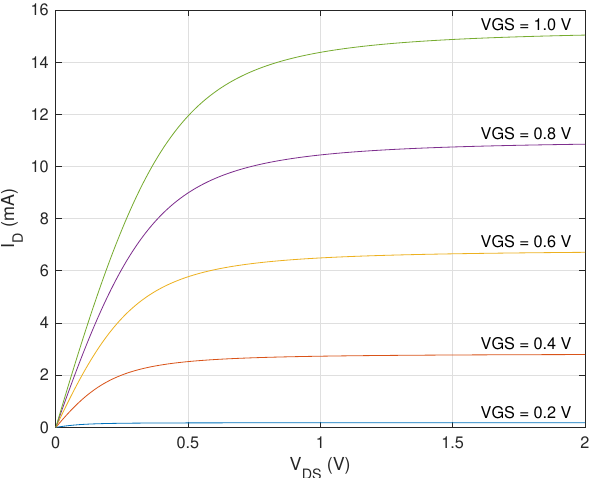
Figure 5. Simulated output voltage characteristics of a CNT-FET as used in the input stage of the LNA ( W = 100µm and L = 200nm). Its transition frequency f t was found to be around 45 GHz at V GS = 0.7V and V DS =